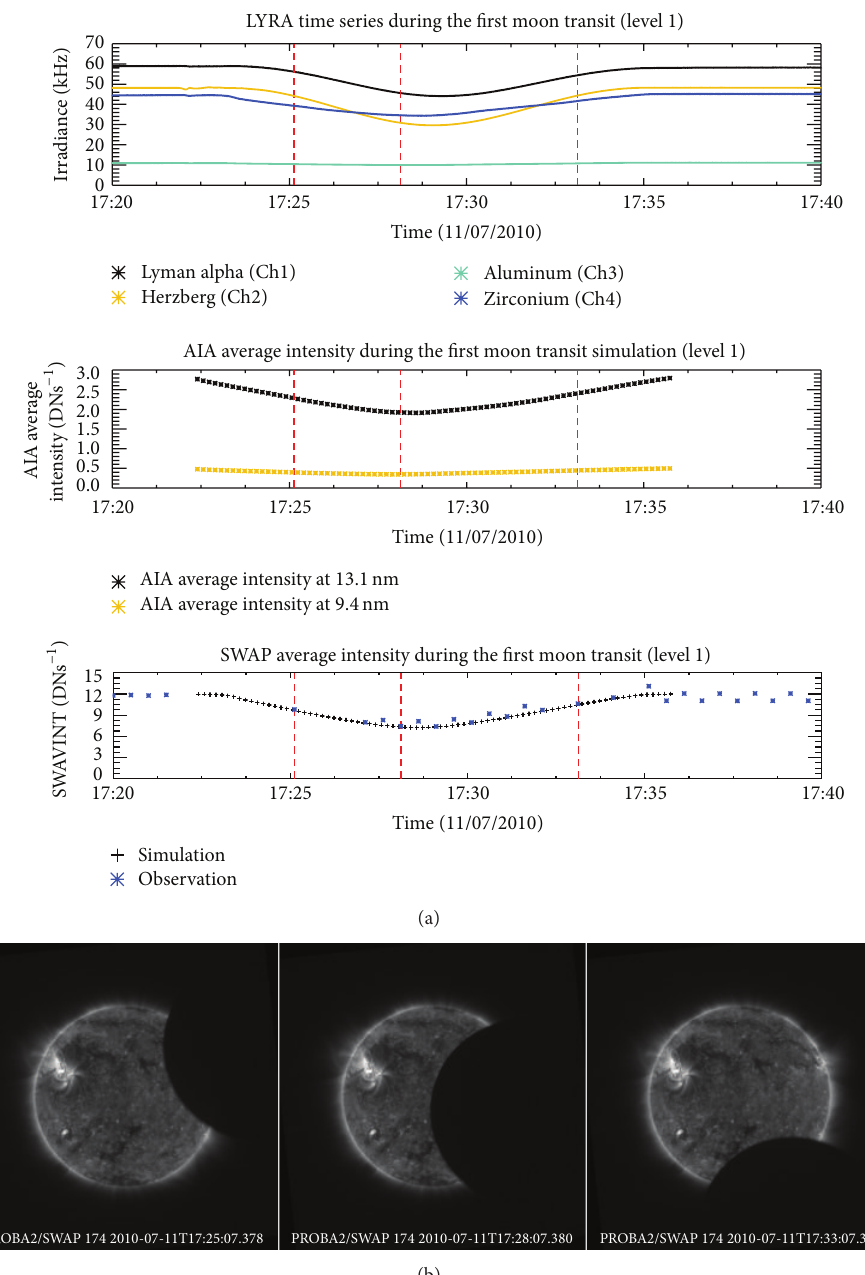
Figure 8: LYRA level 1 data measured by all four channels of unit 2, measured and simulated SWAVINT, and simulated AIA average intensity variations during the first transit of the Moon (a) together with certain SWAP images taken during the first transit of the Moon (b) whose times of observation are indicated in vertical lines on the